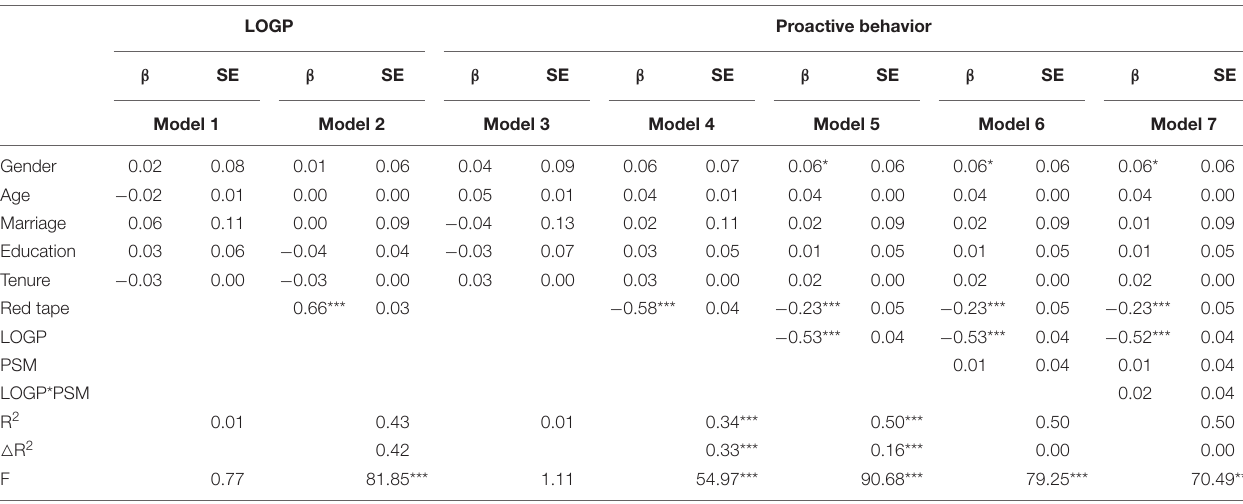
TABLE 4 | Results of hierarchical regression analyses.